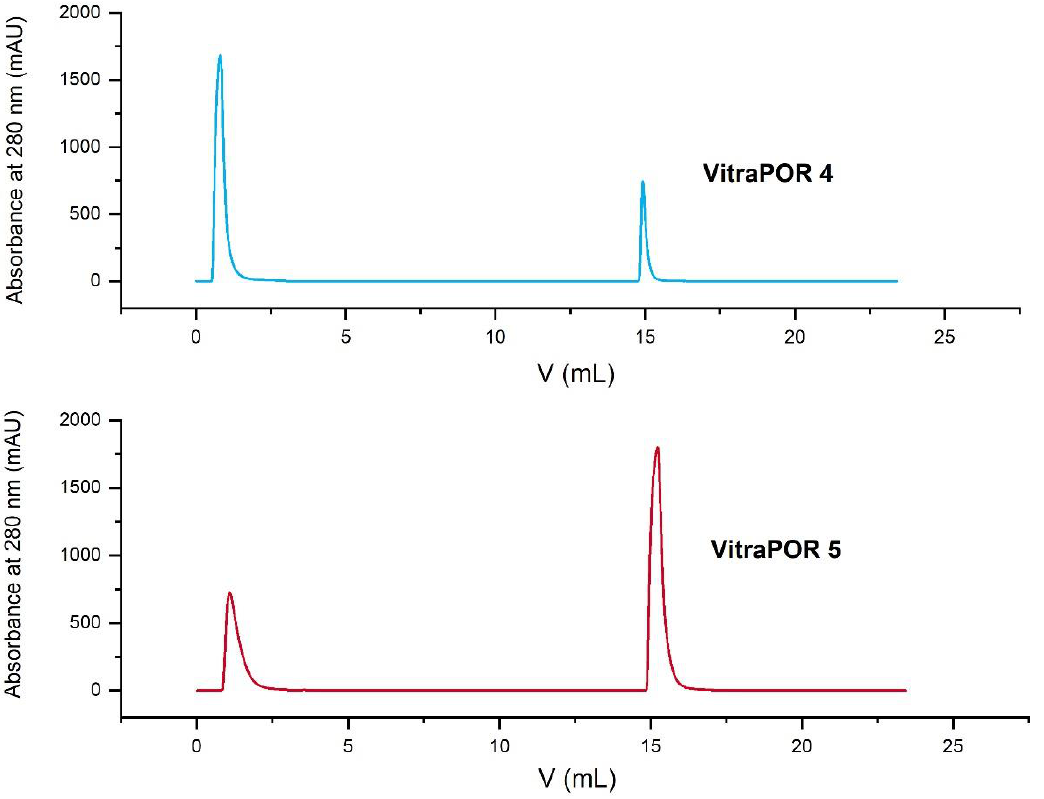
Figure 11. IgG capacity of the column materials VitraPOR 4 (medium) and VitraPOR 5 (ultra fine). In both experiments, the same amount of immunoglobulin was injected (5 mg). For VitraPOR 4, a capacity of 0.7 mg IgG (0.93 mg/mL), and for VitraPOR 5, a capacity of 4.1 mg IgG (5.5 mg/mL) was determined, which is a factor of about 6.